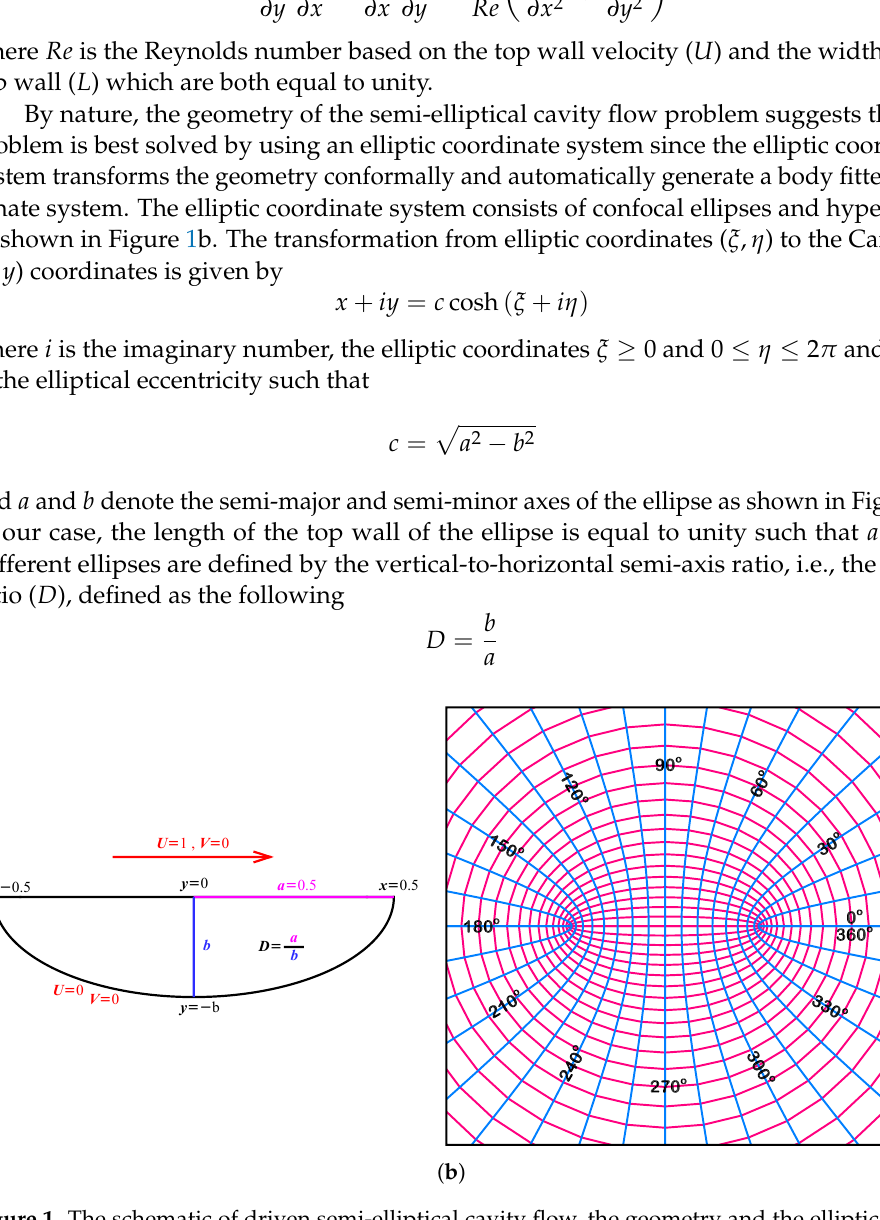
Figure 1. The schematic of driven semi-elliptical cavity flow, the geometry and the elliptic coordi- nate system. ( a ) Schematic of semi-elliptical cavity flow. ( b ) Elliptic coordinate